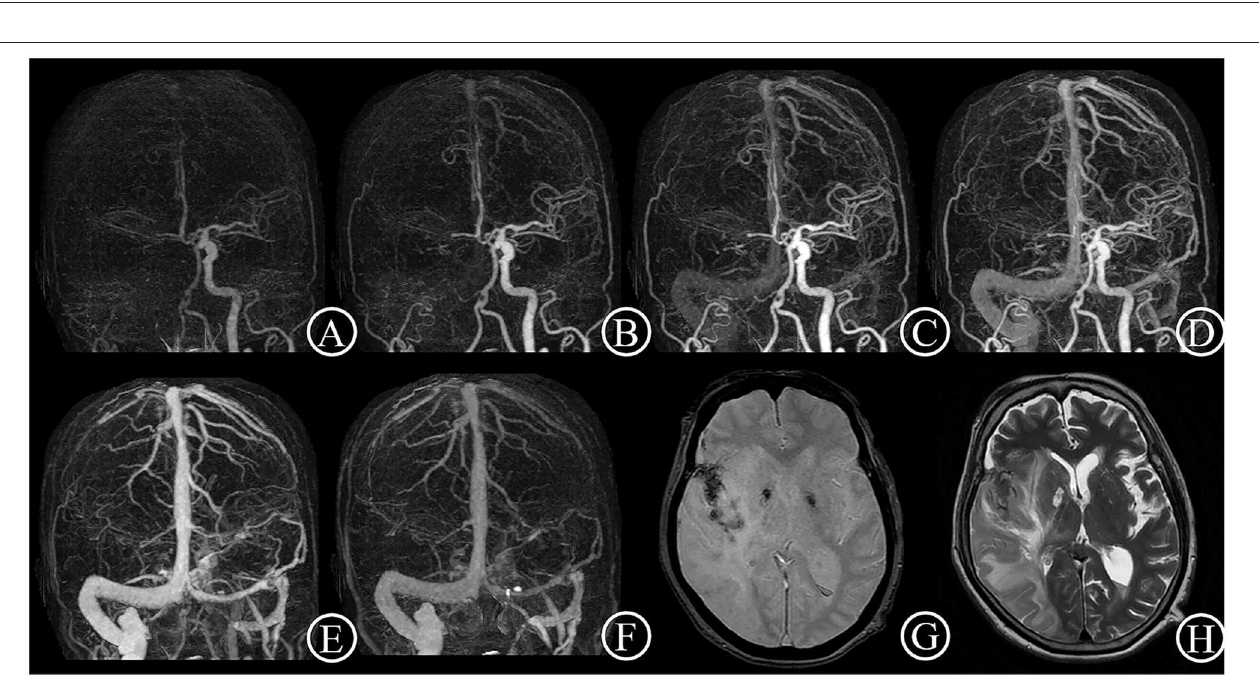
FIGURE 2 | Poor collateral case. One 84-year-old female patient suddenly suffered from inability to lift left upper limb for 1.5h. She had an initial NIHSS score of 11 and a mRS score of 4 after 3 months. 4D CTA (A–F) showed occlusion of right distal carotid artery and right middle cerebral artery, and few collateral vessels in the lesion side in any phase. Thus, the patient got a 4D CTA collateral circulation score of 0. The T2 star (G) and T2WI (H) on day 7 showed a large acute infarct lesion with hemorrhage transformation.